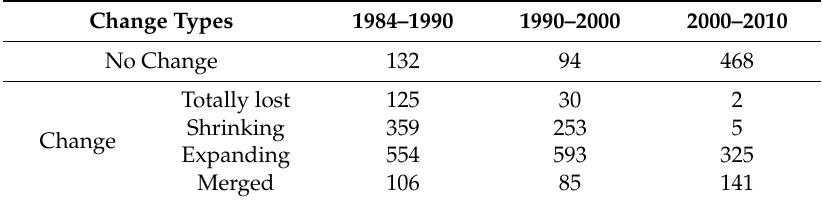
Table 4. The numbers of villages in different types of